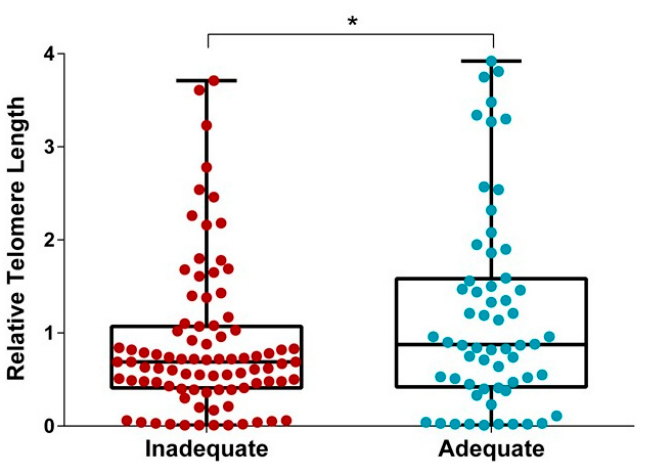
Figure 4. The comparison of telomere length of cfDNA from amniotic fluid between adequate and inadequate gestational weight gain. * p -value < 0.05 based on the Mann–Whitney U Test.